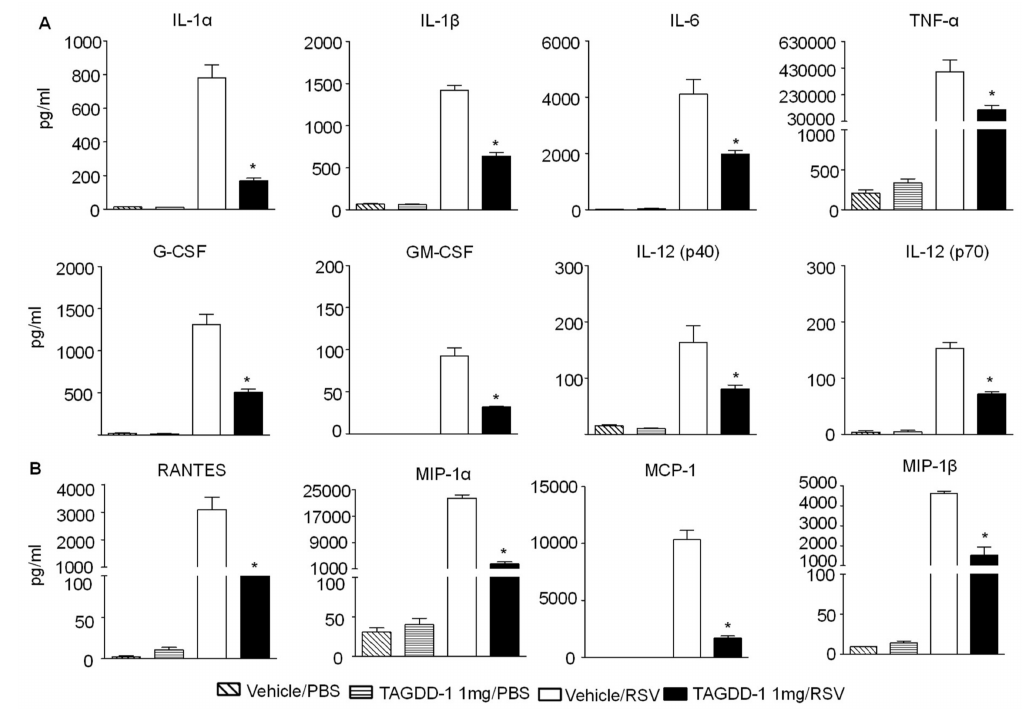
Figure 5. TAGDD-1 inhibits secretion of cytokines and chemokines in response to RSV infection. Mice were treated with TAGDD-1 or vehicle (DMSO), and infected with RSV or sham-infected with PBS. The bronchoalveolar lavage was harvested at day 1 p.i. to measure ( A ) cytokines and ( B ) chemokines by multi-Plex Cytokine detection system. The bar graph represents mean ± SEM ( n = 4–5 mice/group). * p < 0.05, compared to vehicle/RSV